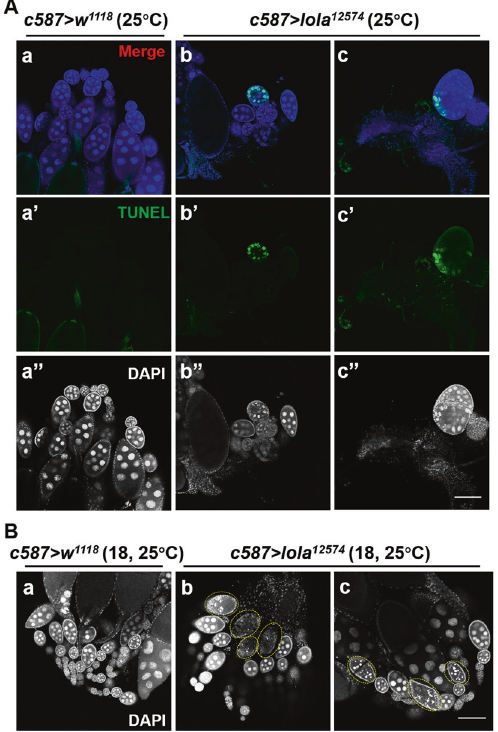
Fig. 5 RNAi of lola induces ovarian apoptosis. A Ovaries from the c587 > w 1118 control line ( a ) and c587 > lola 12574 RNAi line reared at 25 °C from eggs to adults ( b , c ) were stained with TUNEL assay for apoptotic cells ( a ’ – c ’ , green), and nuclei were stained with DAPI ( a ” – c ” , white). In a control ovary, cells were TUNEL-negative ( a – a ” ), while in c587 > lola 12574 RNAi ovaries, TUNEL-positive was observed ( b – b ” , c – c ” ). B The c587 > w 1118 and c587 > lola 12574 RNAi lines were reared at 18 °C from eggs to pupae and then at 25 °C from pupae to adults. Ovaries from 3-4 days c587 > w 1118 and c587 > lola 12574 RNAi adults were dissected and stained with DAPI. DNA fragments were detected in the ovaries of c587 > lola 12574 RNAi adults ( b and c , circled in yellow), but not in the ovaries of c587 > w 1118 control adults ( a ). Scale bar: 100 µm.